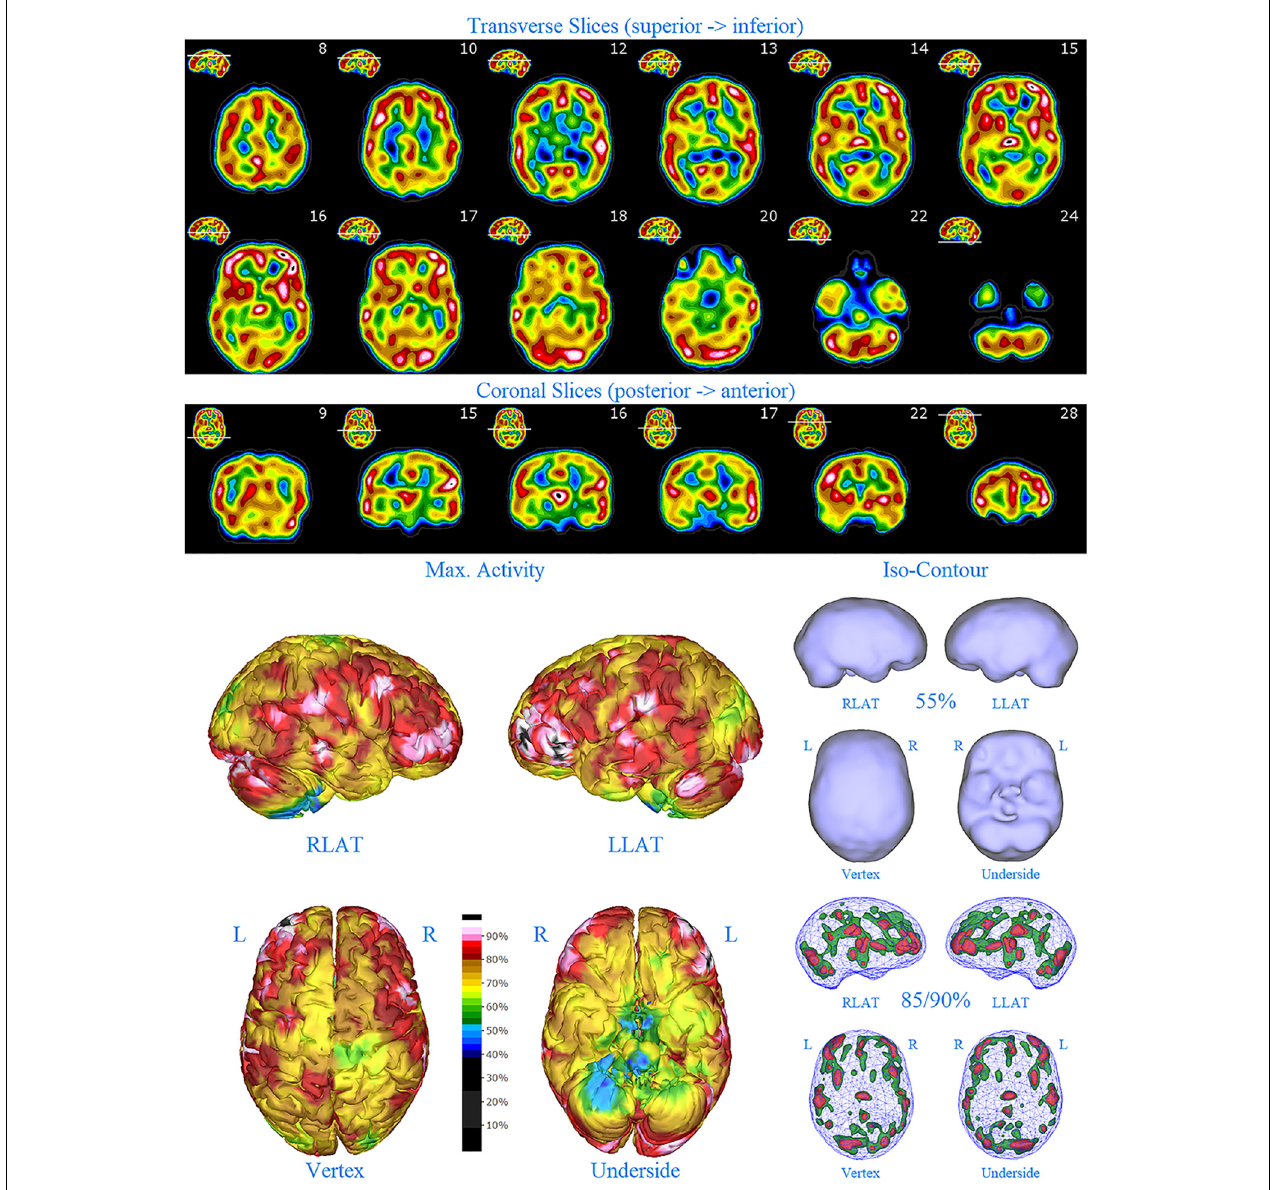
FIGURE 9 | Second perfusion SPECT scan of Patient E. Arrangement, color scales, and views are identical to Figure 1 . Anatomical structures such as the thalamus are positioned similarly to the scan shown in Figure 2 . Labeling was eliminated to avoid obscuring the scan details. Perfusion of the thalamus is increased and asymmetrical. Areas of increased perfusion are considerably more prominent compared to the first scan, particularly in the left frontal